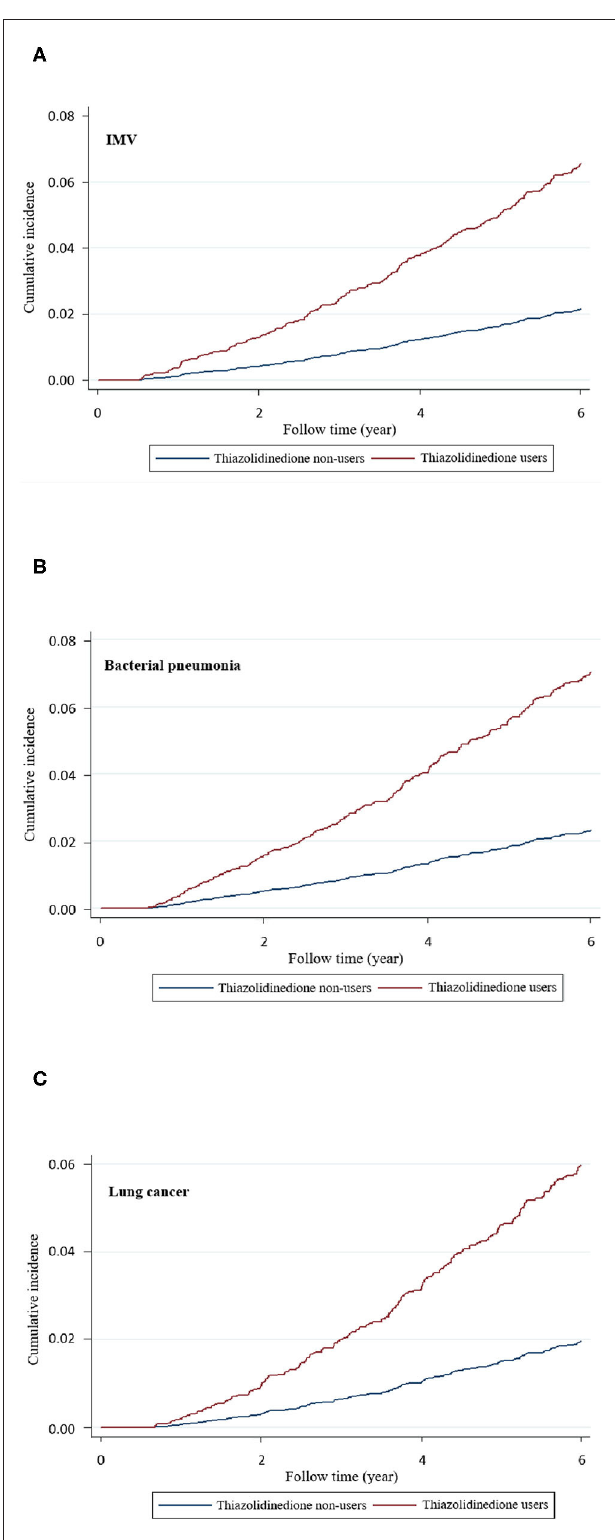
FIGURE 2 | Cumulative incidence of (A) invasive mechanical ventilation (IMV), (B) bacterial pneumonia, and (C) lung cancer in thiazolidinedione users and